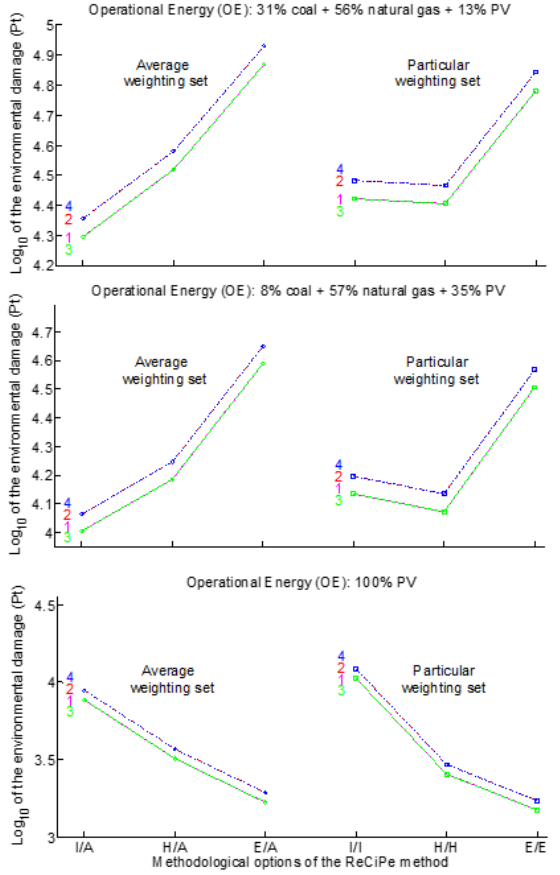
Figure 8. OE stage: environmental damage of CB MinWin (1), CB MaxWin (2), AAB MinWin (3), and AAB MaxWin (4), evaluated with ReCiPe2016 endpoint single-score method using individualist/average (I/A), hierarchist/average (H/A), egalitarian/average (E/A), individualist/individualist (I/I), hierarchist/hierarchist (H/H), and egalitarian/egalitarian (E/E). Table 7. OE stage: p -values of paired differences of CB MinWin (1), CB MaxWin (2), AAB MinWin (3), and AAB MaxWin (4).